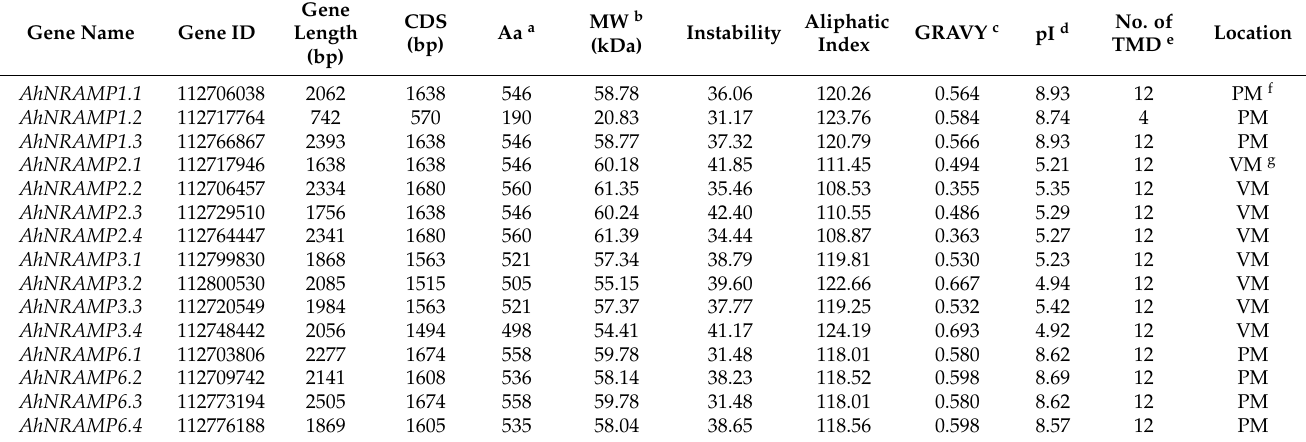
Table 1. Molecular characterization of AhNRAMP genes and corresponding proteins in peanut.